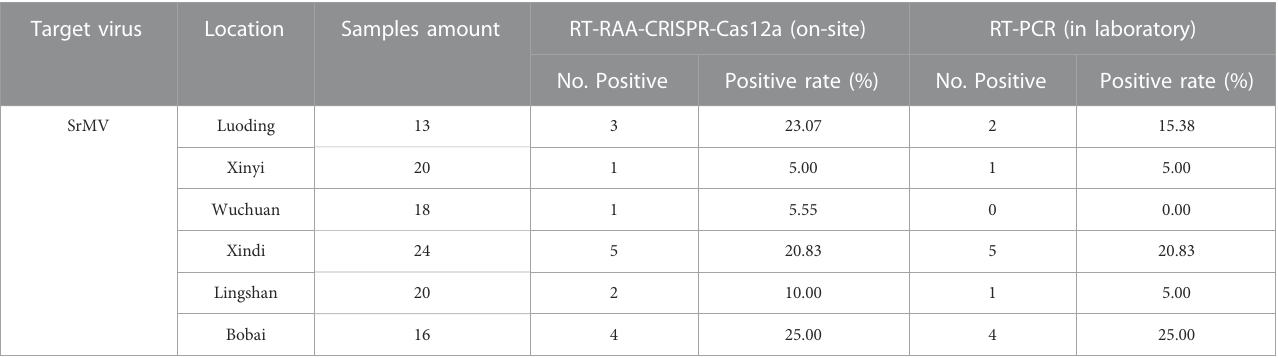
TABLE 1 Field samples detection for SrMV by two methods. Target